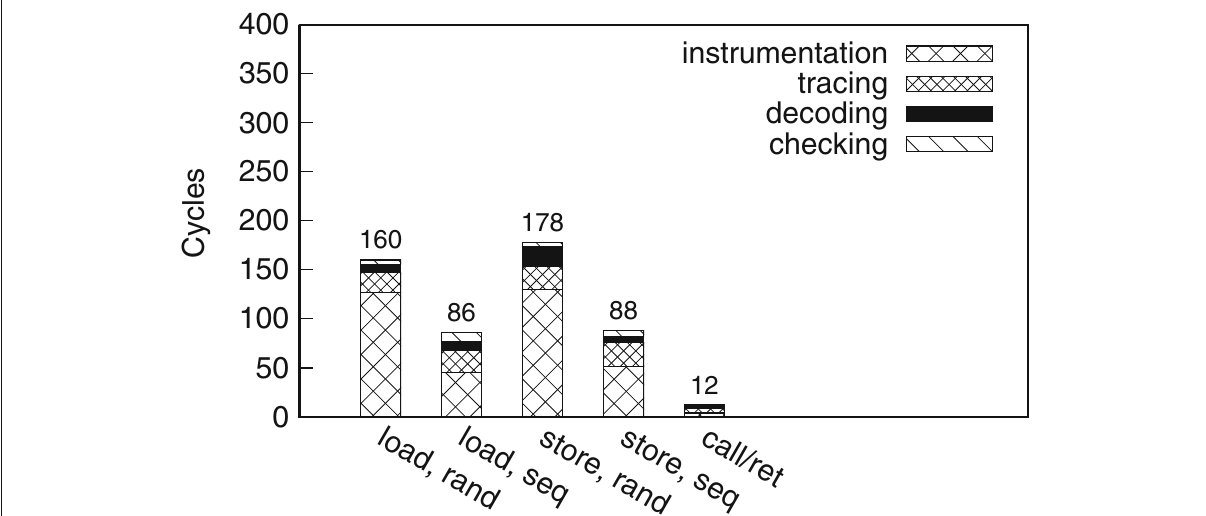
Fig. 6 Cycles of the primitives. Each bar is brokendown to show the cycles spent in each step. instrumentation : the cycles of executing the instructions of the primitives running in user-mode. tracing : the time that Intel PT writes packets to memory. decoding : the time for the Trace Analyzer to decode packets for the event. checking : the time cost of remembering a stored value or checking a loaded value